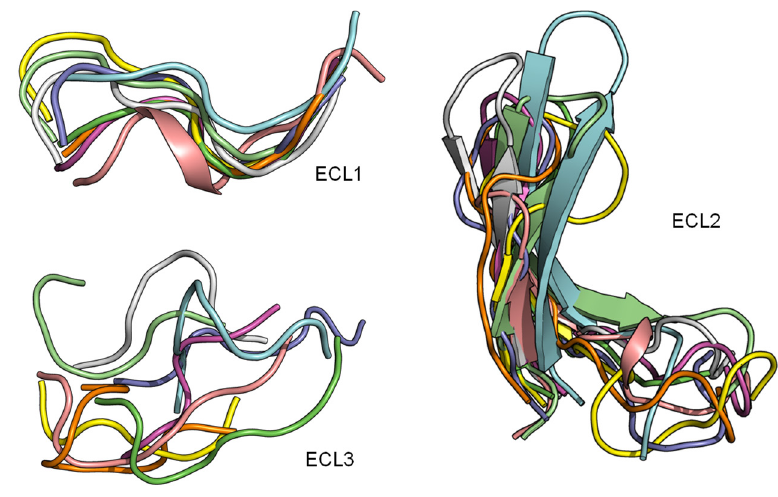
Figure 4. ECL1 and ECL2 have a conserved bound conformation compared to ECL3. Overlay of three extracellular loops.